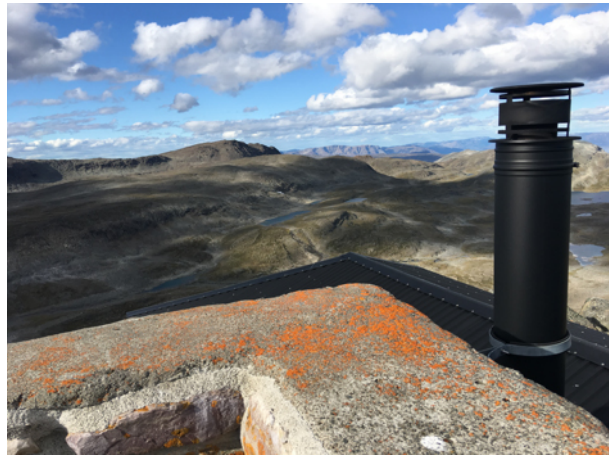
Figure 6. A wide view from the top of the Haldde Observatory (photo: Asgeir Brekke,